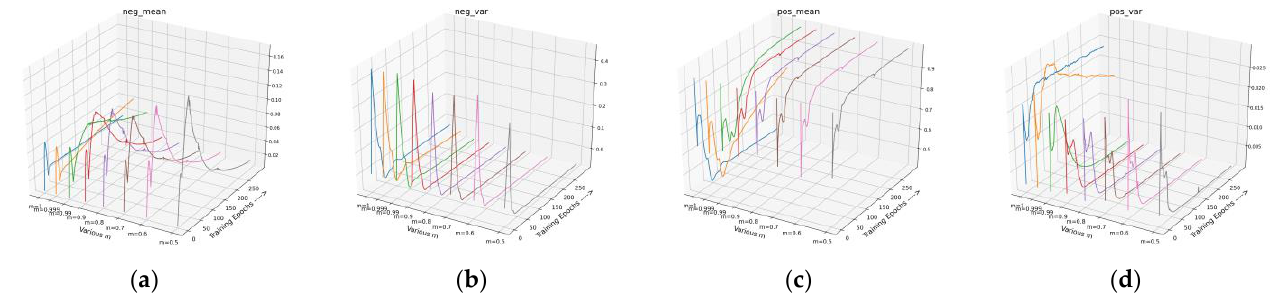
( d ) Figure 18. Similarity statistics of various 𝑚 in SCL training on the Pavia University dataset: ( a ) mean of negative similarity; ( b ) variance of negative similarity; ( c ) mean of positive similarity; ( d ) variance of positive similarity. Different colors corresponds to different values of 𝑚 .